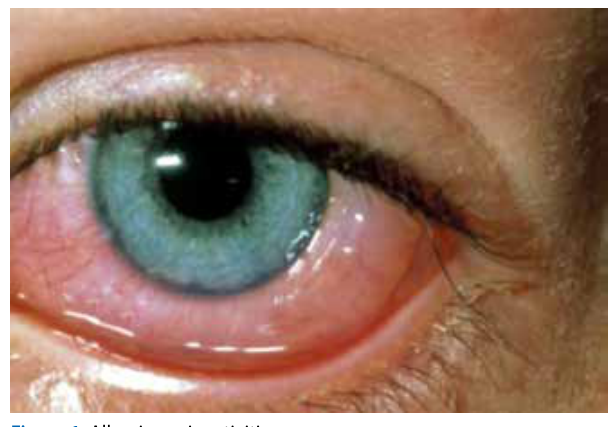
Figure 2: Atopic keratoconjunctivitis Image available from http://www.reviewofoptometry.com/ CMSImagesContent/2005/4/2_1407_0.jpg